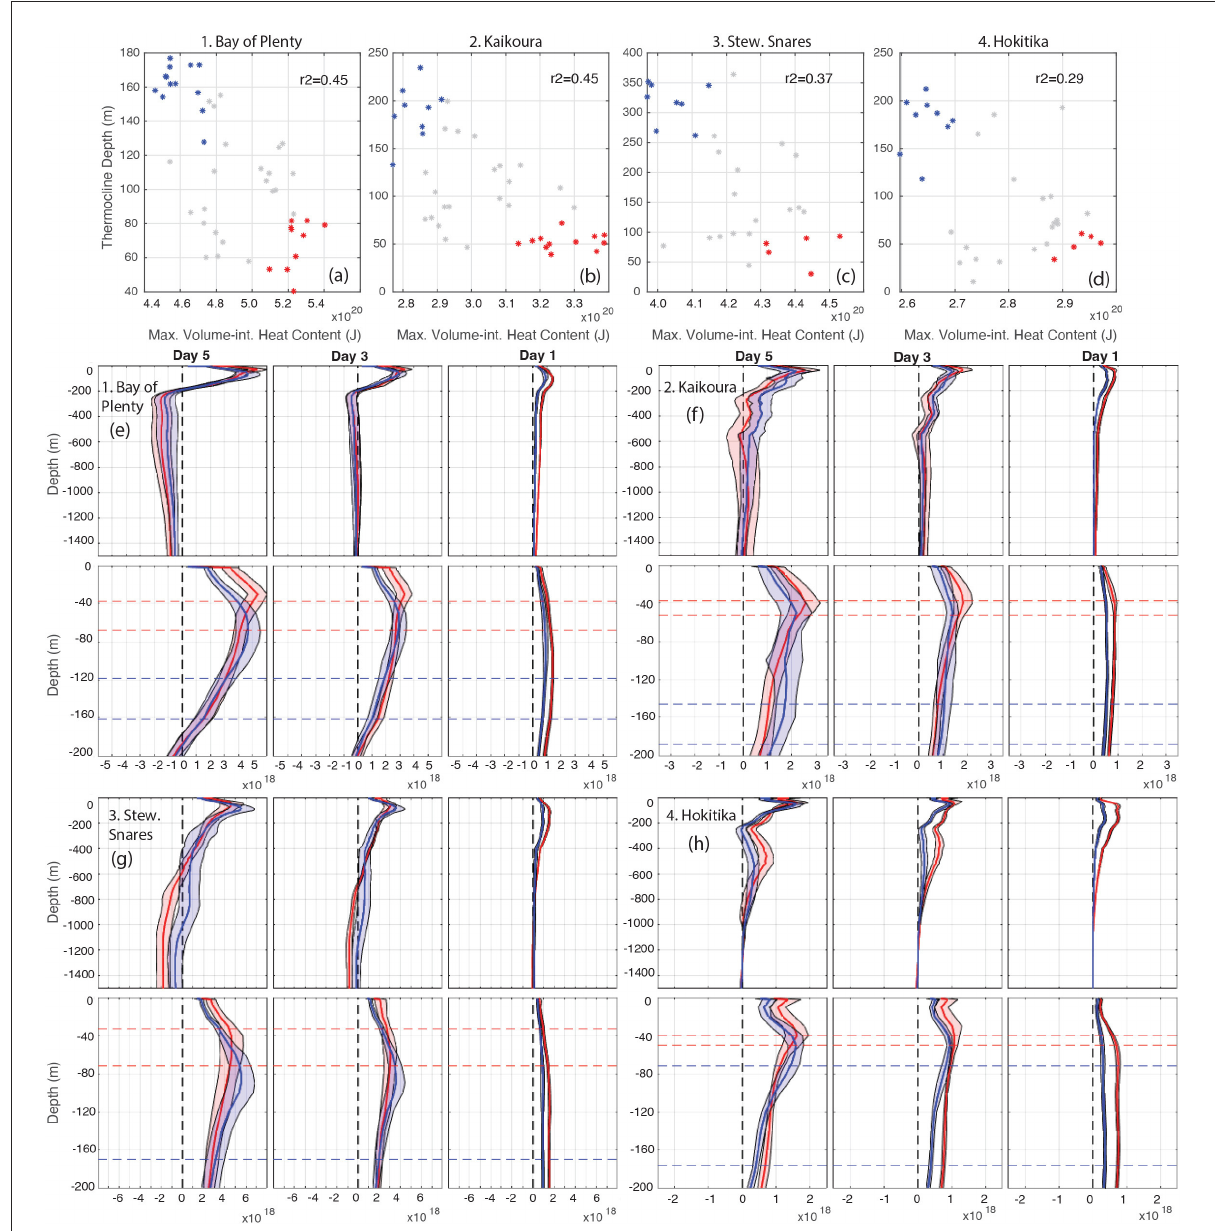
FIGURE6 MHW magnitude versus mean thermocline depth over each of the regions and over the 5 days (a–d) . MHWs are clustered into mag > 65th %tile and TD < 35th %tile (red) and mag < 35th %tile and TD > 65th %tile (blue). These clusters are used for the composite profiles (e–h) . Profiles show the sensitivity to temperature outside of the region scaled by the 5-day standard deviations for composites of high and low magnitude MHWs down to 1500 m (top) and zoomed in to the upper 200 m (bottom) , for days 5, 3 and 1 prior to the first day of the MHW